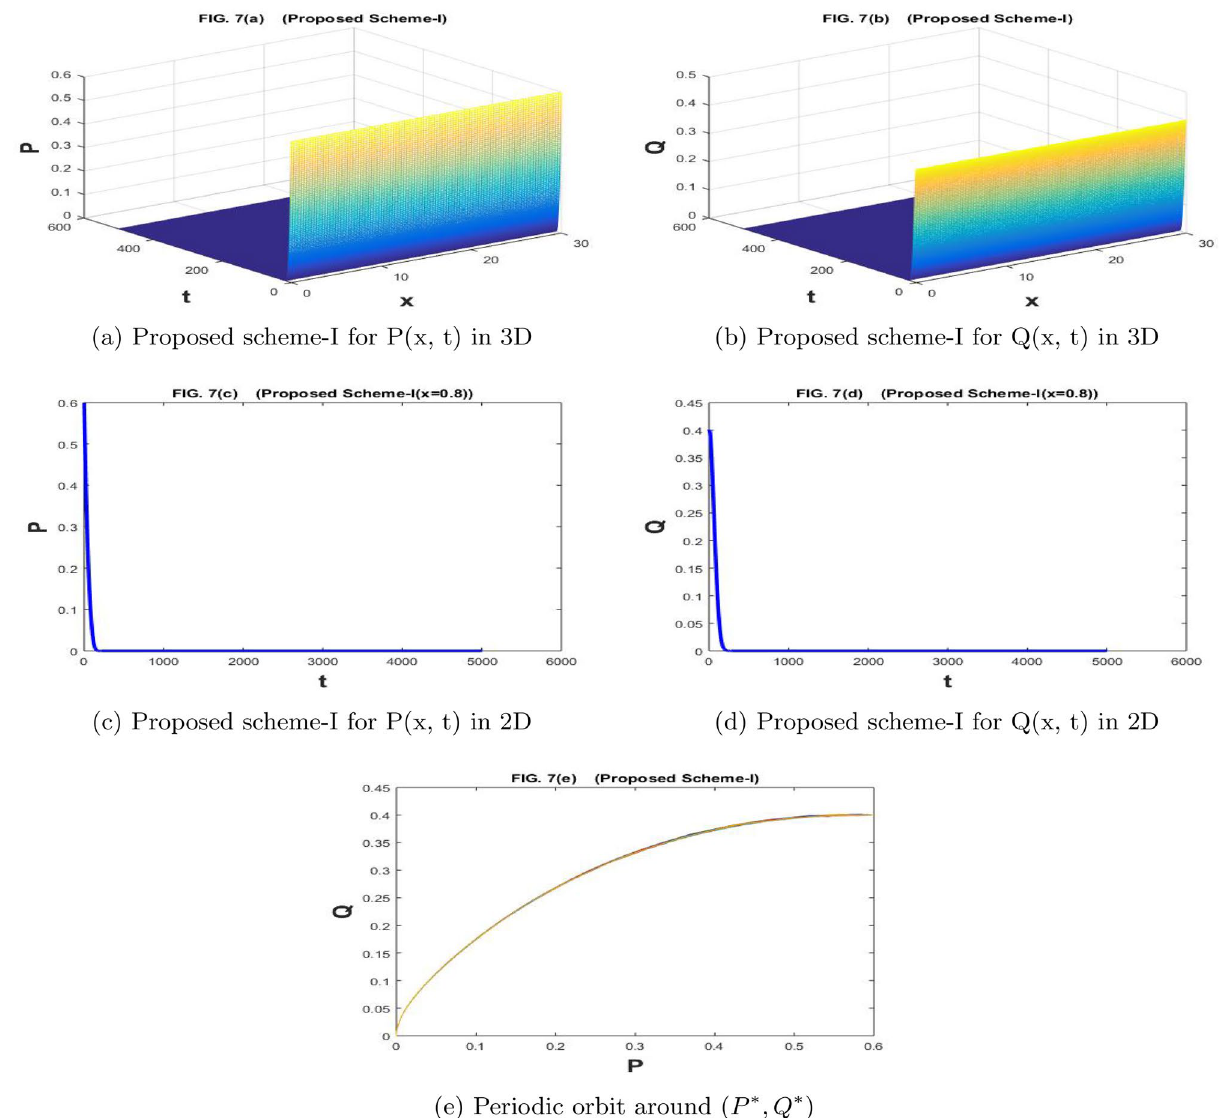
Figure 7. The subfig ( a and c ) and ( b and d ) represents the numerical approximation of P ( x , t ), and Q ( x , t ) respectively by proposed scheme-I. The subfig ( e ) represents the periodic orbit around ( P ∗ , Q ∗ )